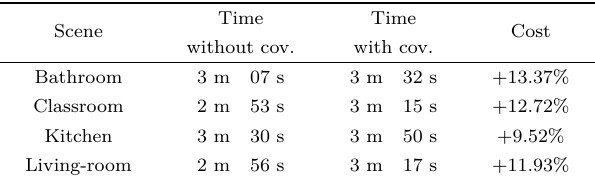
with four scenes, rendered at 128 spp and 512 × 512